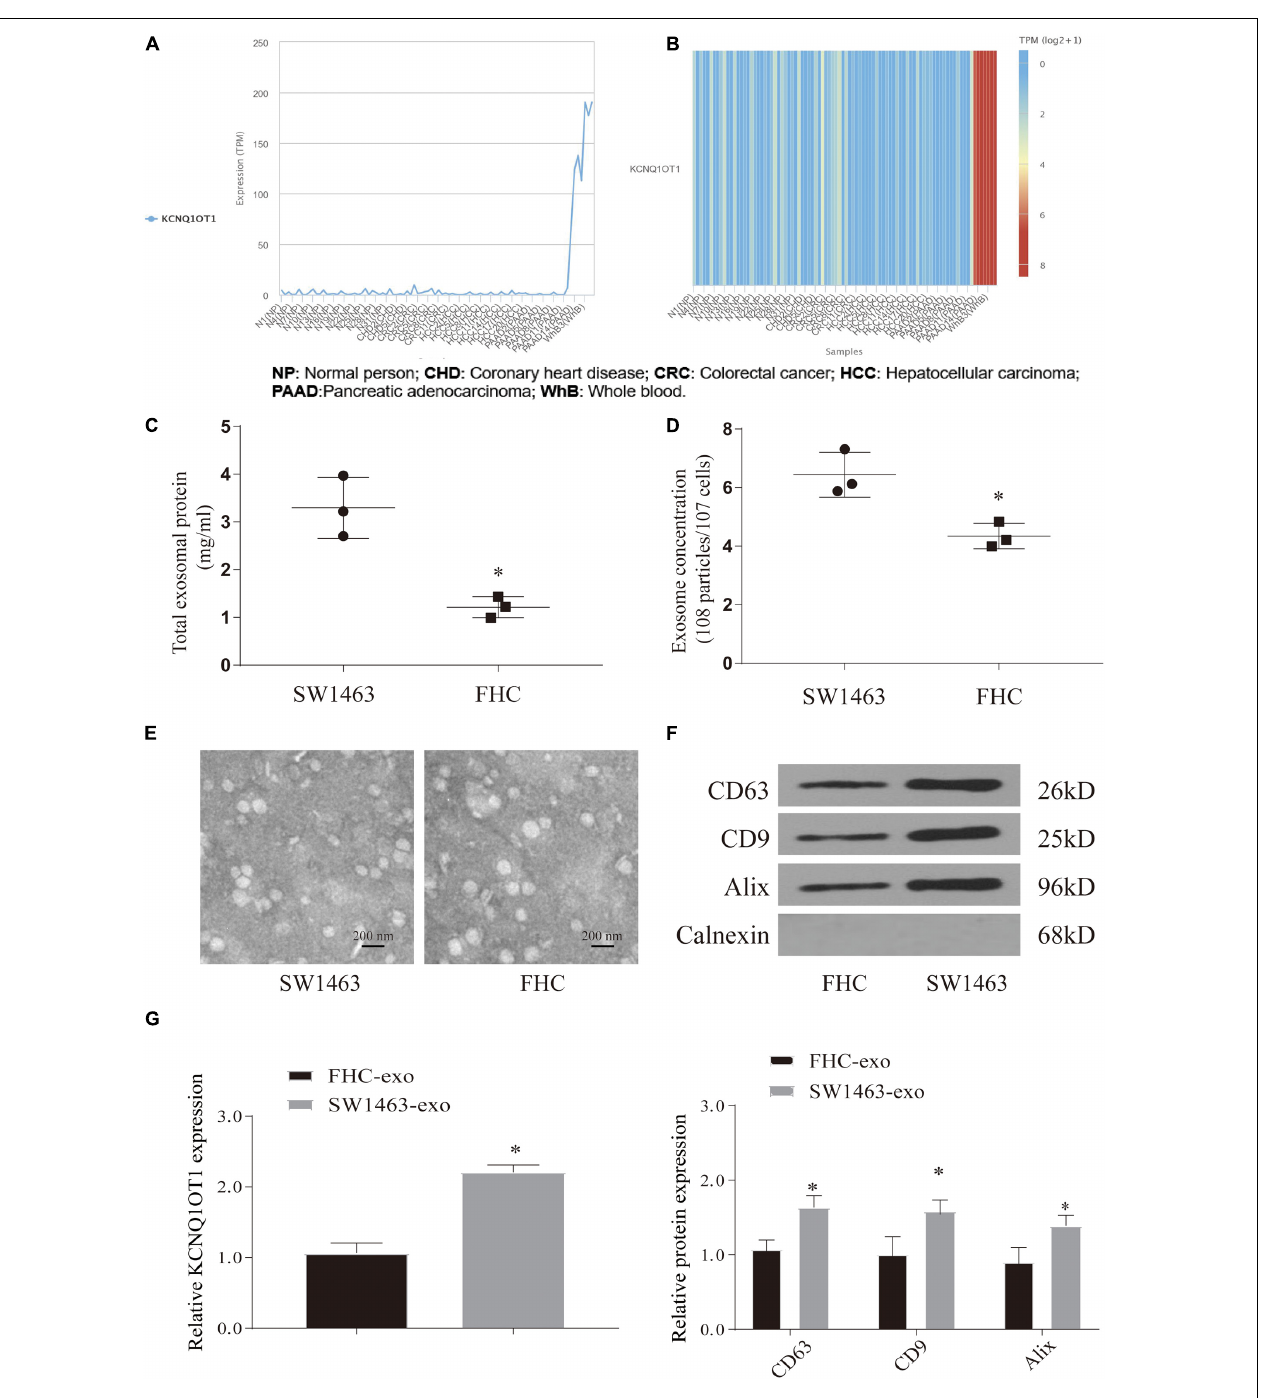
FIGURE 2 | Colorectal cancer (CRC) cells can release a large amount of exosomes containing KCNQ1OT1. (A,B) Analysis of the expression difference of KCNQ1OT1 in different tumor cell exosomes in exoRbase database. (C) Total exosome protein expression. (D) The concentration of exosomes secreted in different cells by nanoparticle tracking analysis (NTA). (E) Morphology of exosomes in each group under electron microscope. (F) Expression of exosome markers in different tumor cells. (G) The expression of KCNQ1OT1 in exosomes derived from different cells. ∗ p < 0.05 compared with the FHC-exo group.